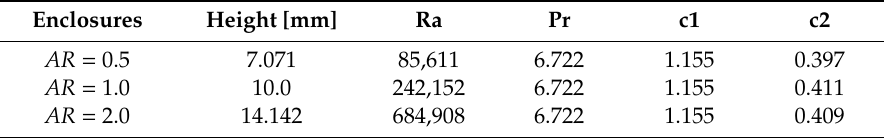
Figure 9. The Nusselt number of three different enclosures with different hot sides. ( a ) AR = 0.5; ( b ) AR = 1.0; ( c ) AR = 2.0. Table 2. The corresponding parameters and coefficients in Figure 10.